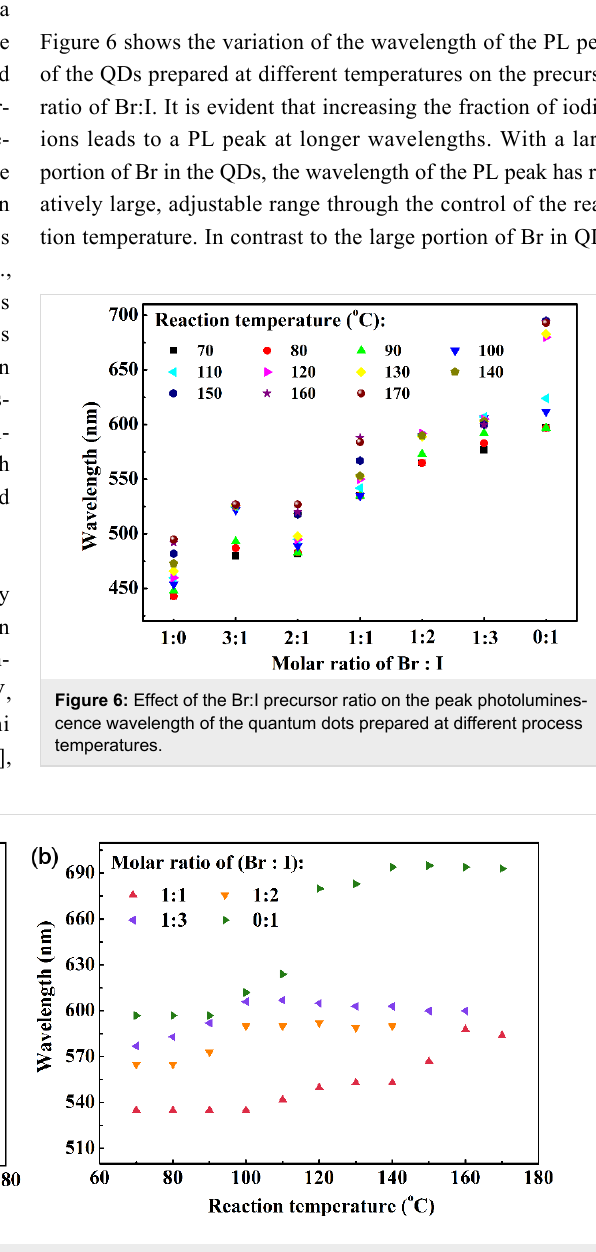
Figure 5: Temperature effect on the photoluminescence peak of the quantum dots prepared with different precursor ratios of Br:I.